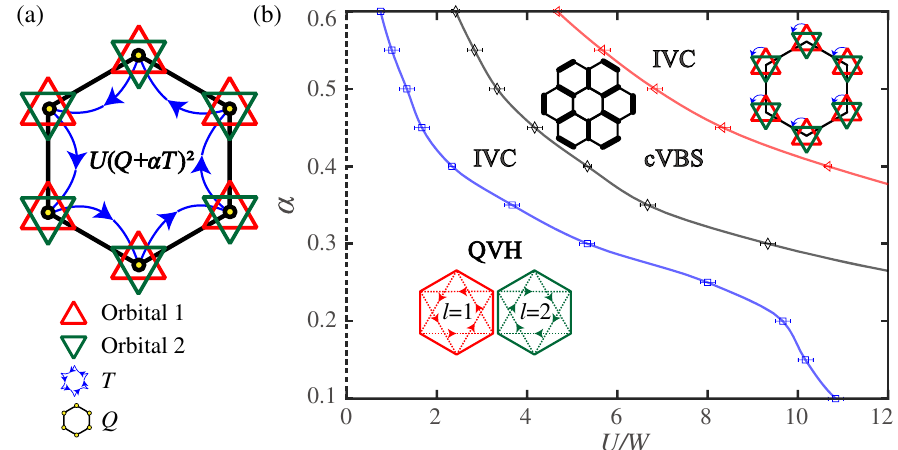
FIG. 1. Ground-state phase diagram at charge neutrality obtained via QMC simulations. (a) Schematics of the model: Each lattice site on the dual moir´e honeycomb lattice contains two valleys l ¼ 1 , 2 (red and green triangles) and spins σ ¼ ↑ ; ↓ (not shown), with spin- valley SU(4) symmetry. The interactions act on every hexagon and consist of the cluster charge term Q ⬡ (yellow dots) and the assisted- hopping interaction term T ⬡ (blue arrows). (b) Ground-state phase diagram, spanned by the U=W and α axes, obtained from QMC simulations. The y axis at U ¼ 0 (dashed line) stands for the Dirac semimetal phase. At very small U , the ground state is a QVH phase characterized by emergent imaginary next-nearest-neighbor hopping with complex conjugation at the valley index, as illustrated by the red and green dashed hoppings with opposite directions. The system has an insulating bulk but acquires topological edge states. Upon further increasing U , an IVC insulating state is found, which breaks the SU(4) symmetry at every lattice site by removing the valley symmetry. Because it preserves the lattice translational symmetry, it is ferromagnetic-like. The cVBS insulator, which appears after the IVC phase, breaks the lattice translational symmetry and preserves the on-site SU(4) symmetry. Note that there is a reemergence of the IVC phase for the largest interactions probed. The phase transitions between QVH and IVC (blue line), between the IVC and cVBS (black line), and between the cVBS and IVC (red line) are all first